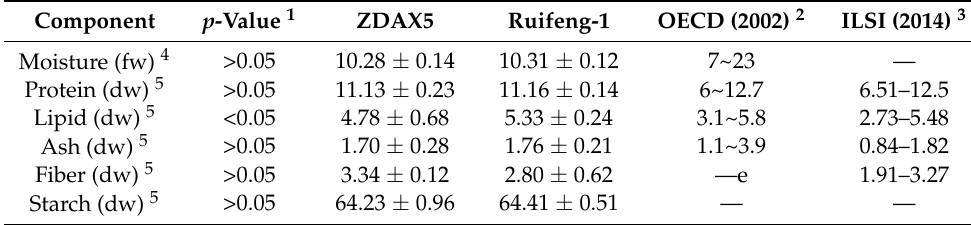
Table 1. Proximate levels in ZDAX5 maize grain and Ruifeng-1 maize grain. Component p -Value 1 ZDAX5